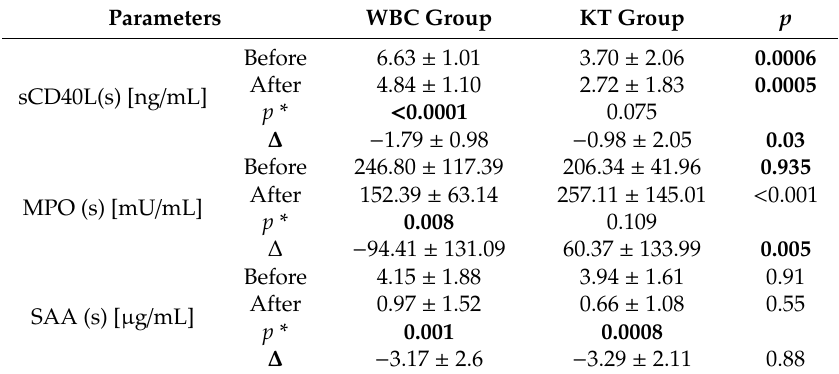
Table 2. Endothelium and inflammatory parameters (mean value ± standard deviation (SD)) in healthy subjects before and after the completion of a cycle of ten whole-body cryostimulation procedures with subsequent kinesiotherapy (WBC group) or a cycle of ten kinesiotherapy-only procedures (KT group), with statistical analyses. p, plasma; s, serum; e, erythrocyte lysates; ∆ , di ff erence prior to post-treatment.